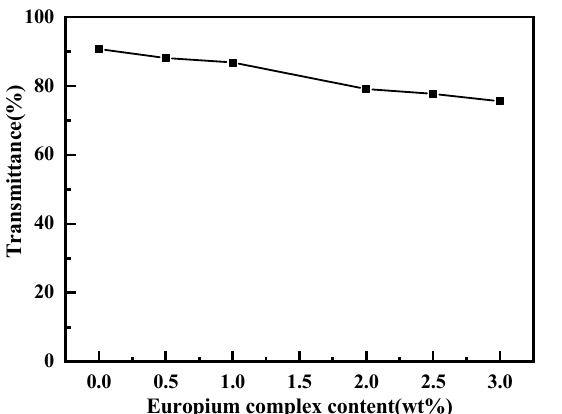
Figure 4. Light transmittance of the polyurethane–europium materials with different mass contents of europium complex.